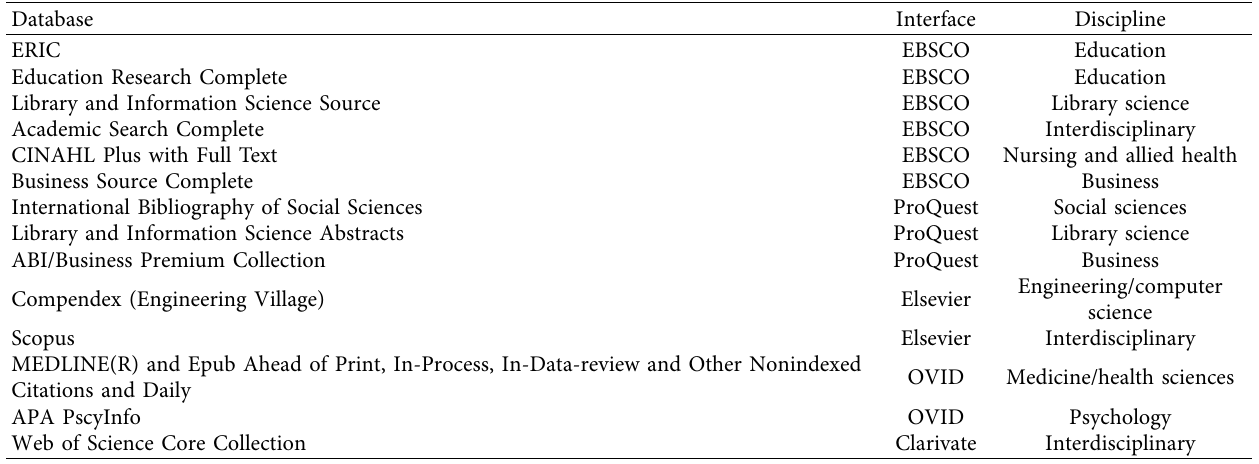
Table 2: Databases